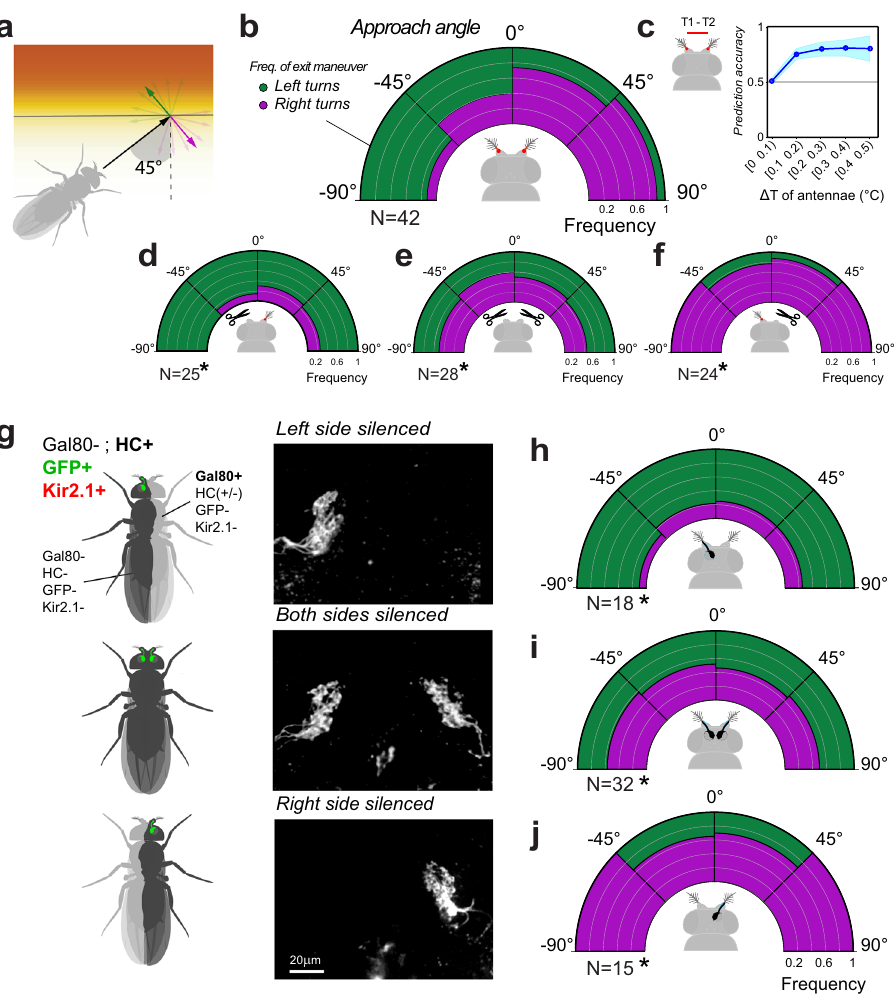
Fig. 4 Differences in antennal input determine the direction of escape turns during thermotaxis. a – c For border interactions, the angle of heading is predictive of the angle of escape. a Schematic of the analysis. The heading angle is quanti fi ed in relation to the isothermal lines of the cool/hot boundary while the escape turn is categorized as “ left ” (green) or “ right ” (purple). b Distribution of left/right escape turns (binned in 45° intervals) as a function of initial heading angle. c Inter-antennal differences >0.1 °C are predictive of escape turn direction (prediction accuracy, bootstrap mean ± STD). d – f Surgical removal of the left ( d ) or right ( f ) antenna biases escape turn direction towards the side of the lesion (GLMM, Wald Test, P left = 6.3e − 5, P right = 9.3e − 4), while removal of both antennae ( e ) abolishes left/right bias (GLMM, Wald test, P both = 2.1e − 4). g Stochastic loss of the Gal4 inhibitor Gal80 produces fl ies in which either the left or right hot TRNs of the arista are genetically silenced and, at the same time, labeled by GFP expression (representative 2- photon stacks of TRN axon terminals are shown to the right, labels are the corresponding genotypes). h – j Stochastic silencing of either left or right hot TRNs (or both), produces a distribution of turning angles similar to that obtained from surgical ablation (( i ) is the control genotype with bi-lateral silencing, see corresponding panel in ( g )) (In all panels N denotes the number of animals, GLMM, Wald test, P left = 9.0e − 6, P right = 2.1e − 2; P both = 2.5e − 5). Note that mosaicism was determined by post-facto dissection and selecting at each generation vehicles that, when tested in the simulated chamber, best matched the fl y ’ s behavior in 4 key areas: probability of “ spontaneous ” turns at 25 °C; avoidance index for the 3 temperatures; fraction of U-turns/crosses at the border between 25° and 30°, 35° and 40 °C, and sensitivity to left/right temperature differences between the antennae (i.e. by matching the probability of a left/right turn given antennal temperature difference at turn start, see Fig. 4c). Amongst the free parameters that determine vehicle responses, two were used to de fi ne a simple sensory transformation, and two parameters speci fi ed the amplitude and time constant for each independent noise function (on sensor and motor output); we also added independent weights to the ipsilateral and contralateral sensor-to-motor con- nections (Fig. 5a, and see “ methods ” for details).